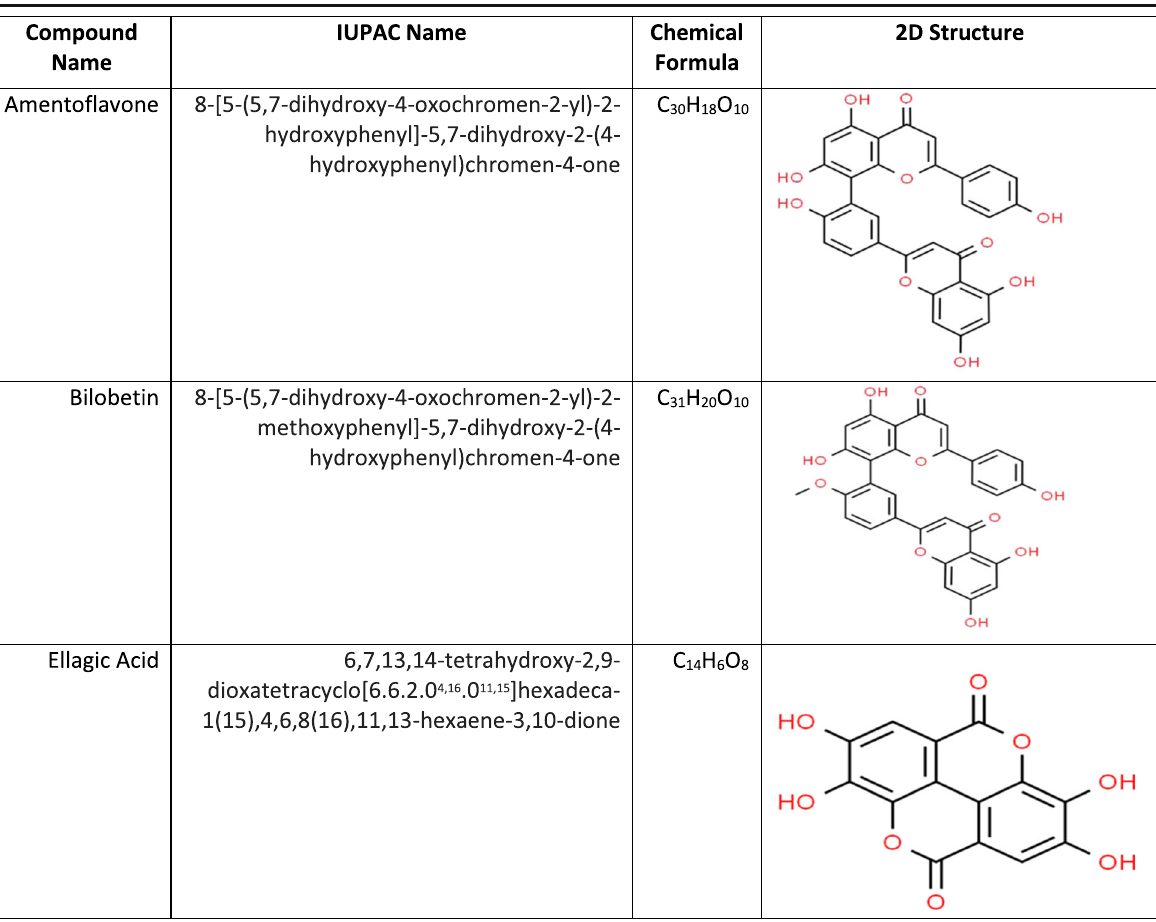
Table 4 Best-performed ligands in overall docking